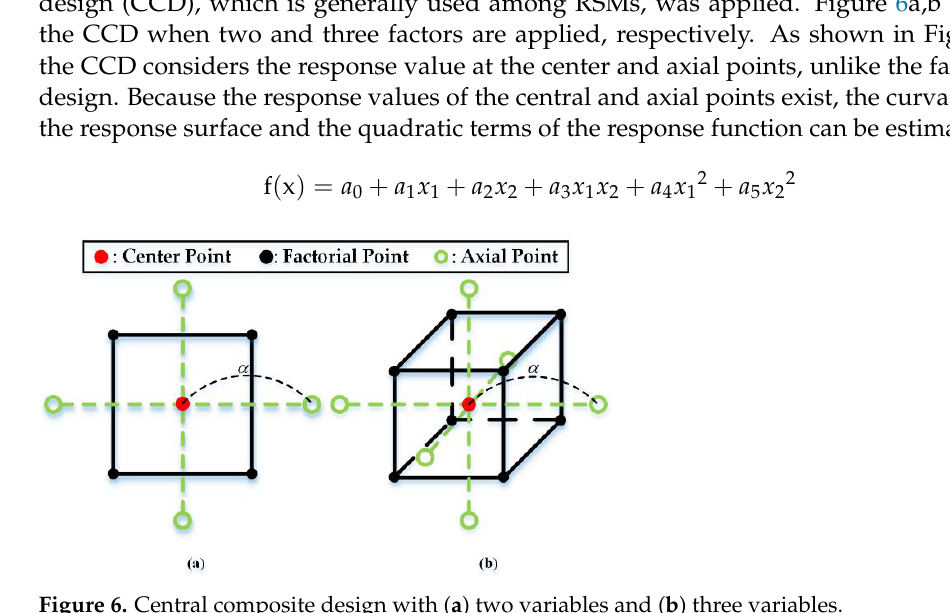
Figure 6. Central composite design with ( a ) two variables and ( b ) three variables.